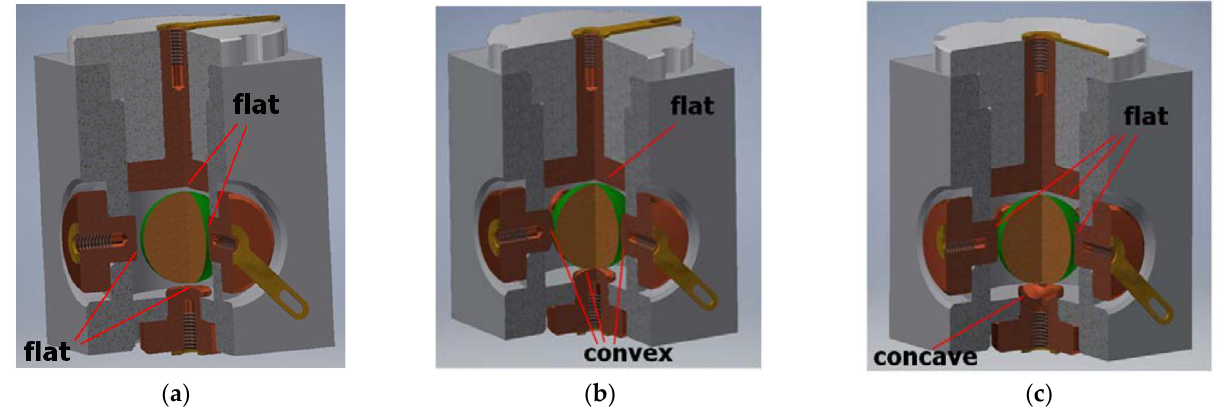
Figure 14. Possible shapes of the contact surface of the lower electrode: ( a ) flat; ( b ) flat and convex; ( c ) flat and concave.